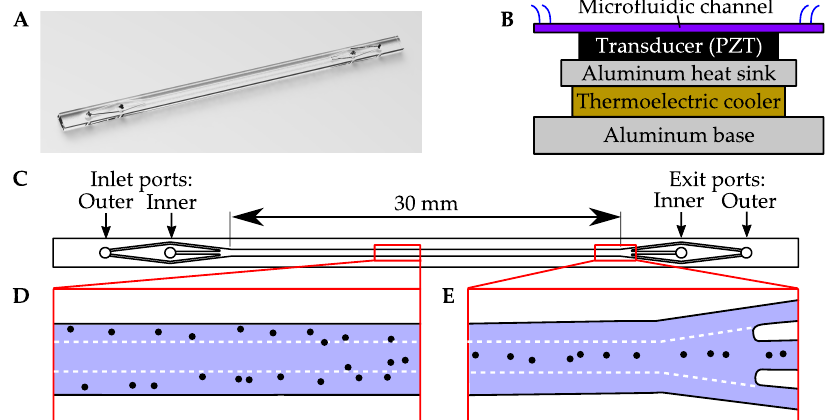
Figure 10. An acoustophoresis device used to test separation of MPs ( A ) A computer rendering of the PS microchannel. ( B ) A schematic diagram of the microchannel mounted to a transducer and cooling apparatus. ( C ) A top view of the microchannel, showing the trifurcated inlet and outlet ports ( D ) A section of the channel that illustrates acoustophoretic focusing of particles during co-flow operation. Particles are diverted from an outer stream toward the center of the channel. The white, dotted lines indicate the approximate boundaries of adjacent fluid streams. ( E ) Toward the end of the channel, particles are shown in the center of the channel, exiting the inner exit port.